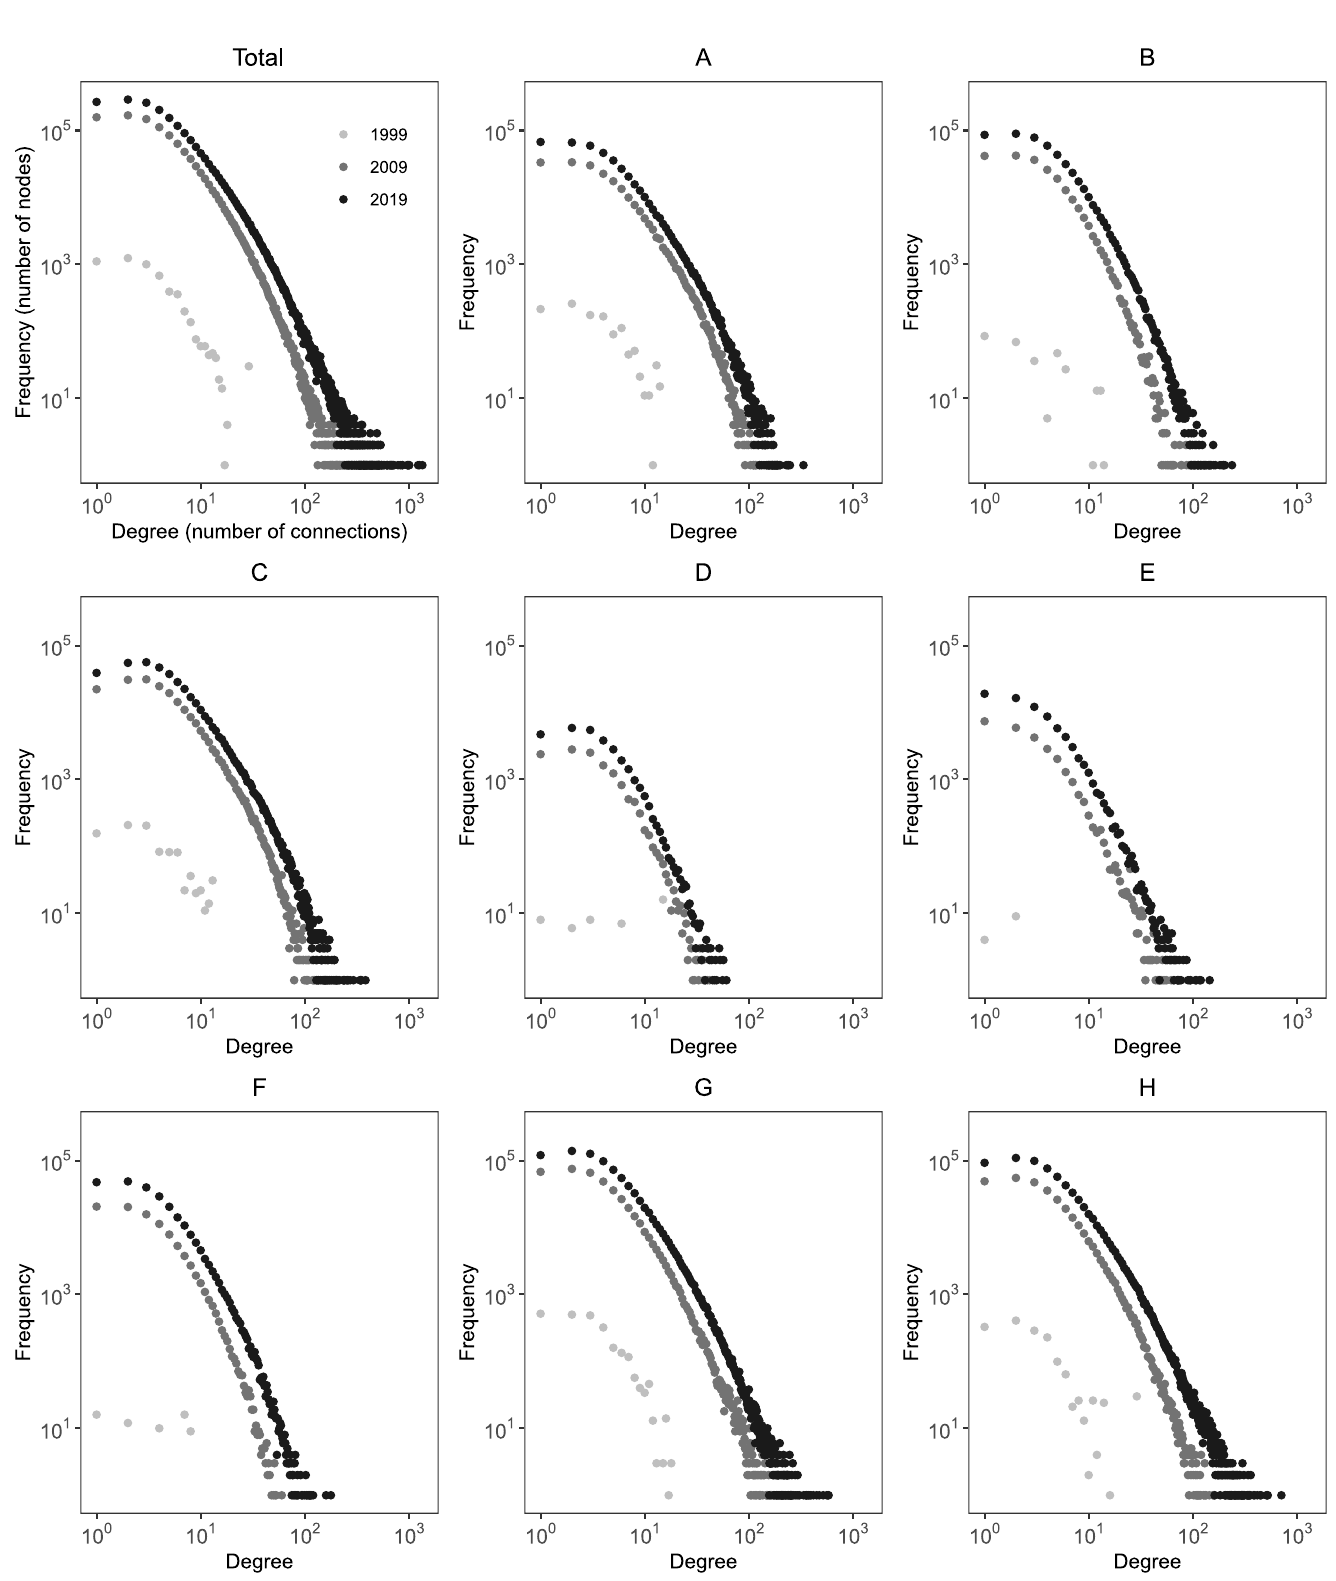
Fig 2. Histogram: Distribution of inventors according to the number of connections by technological field, 1999, 2009 and 2019.